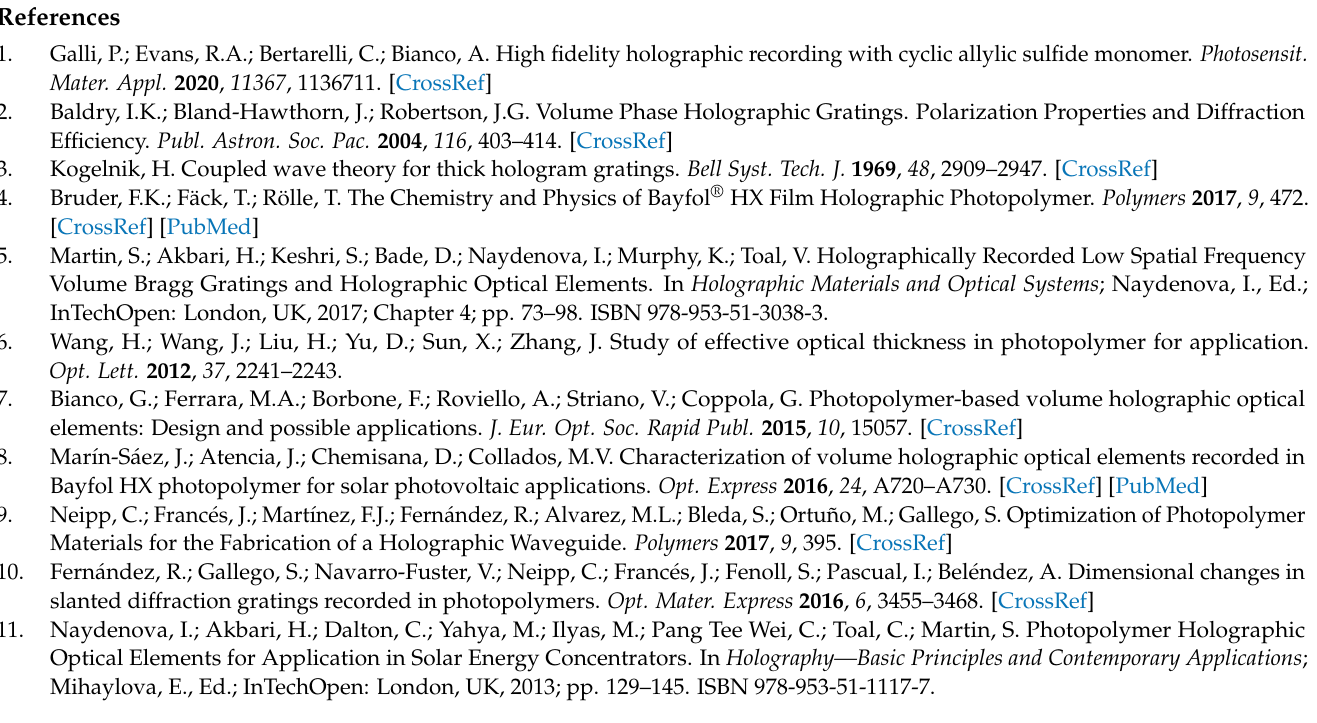
Table S1: Max RIM achieved by heating during dark process at different